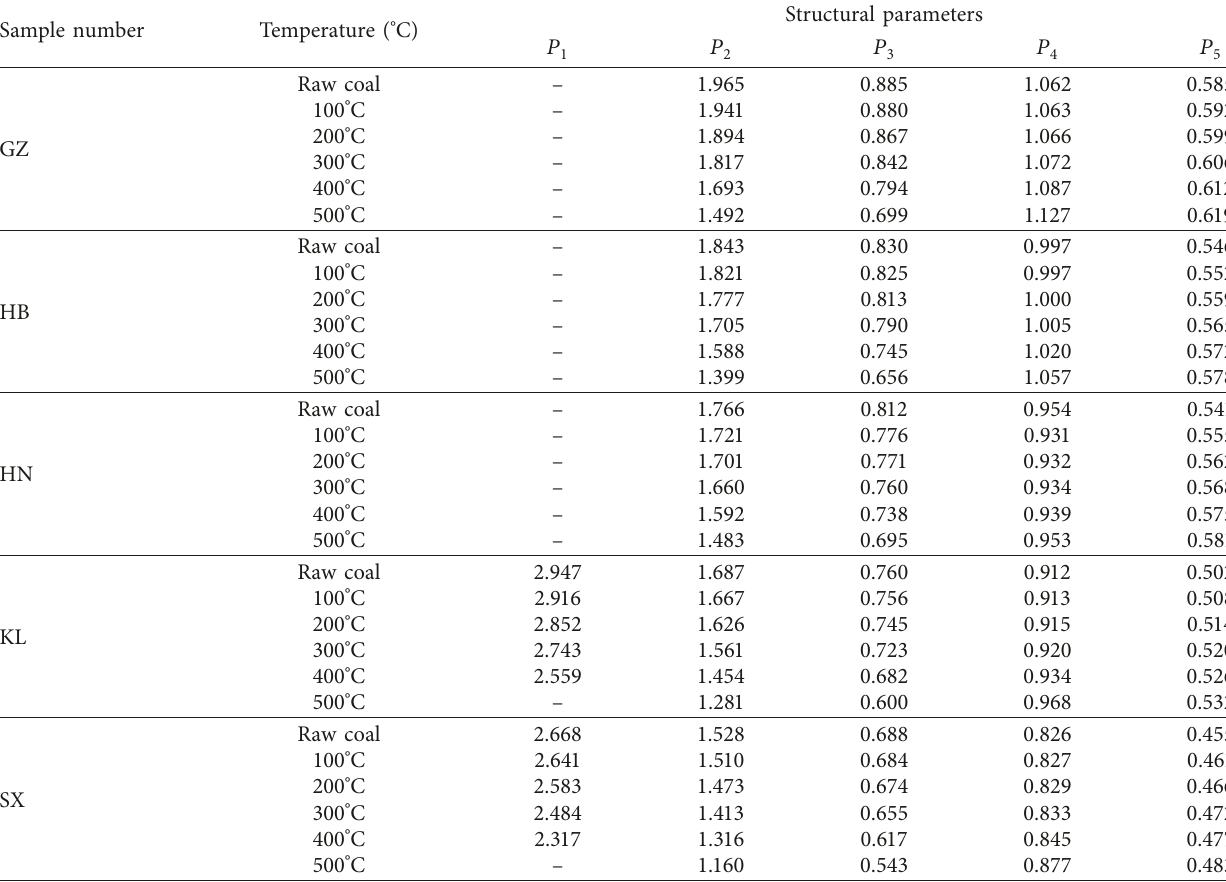
Table 2: Statistic results of the infrared spectral structural parameters of five coal samples before and after pyrolysis. Sample